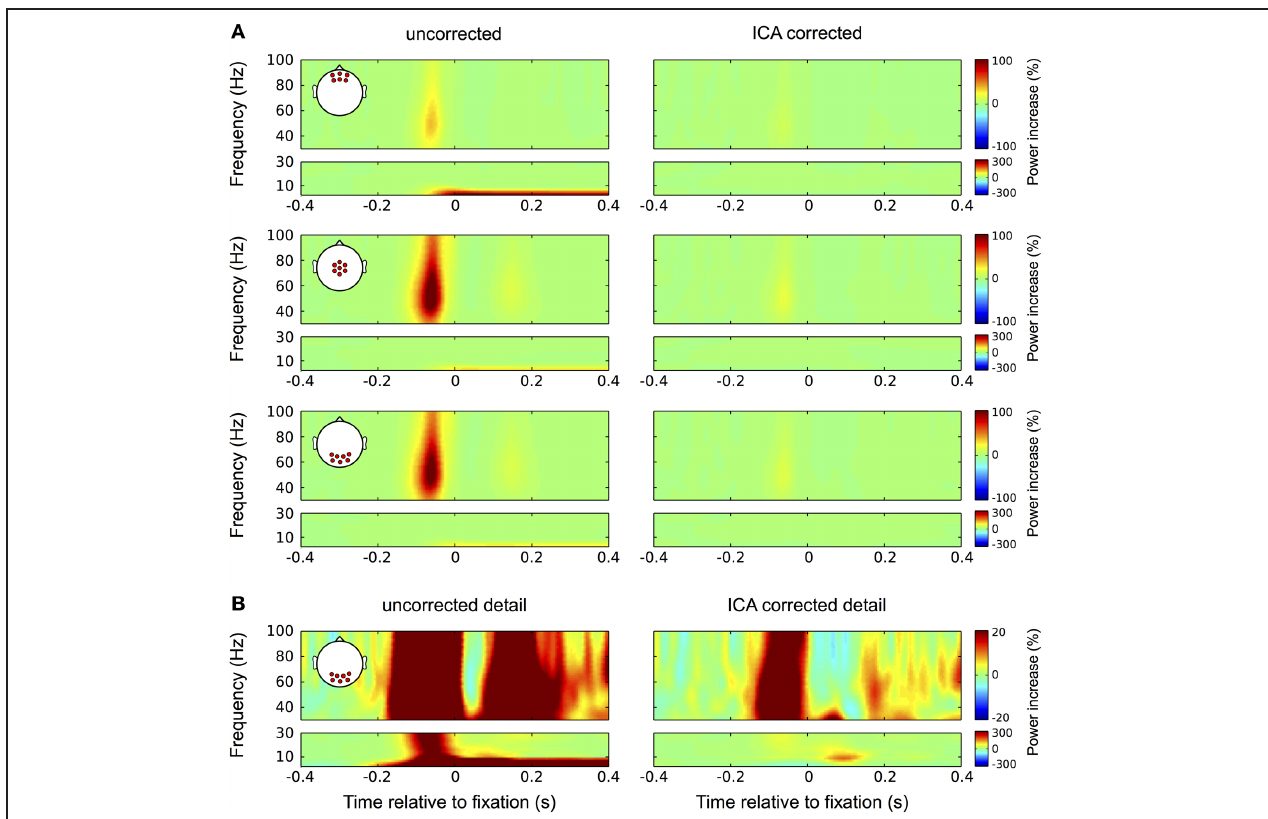
FIGURE 10 | Correction in the time-frequency domain. (A) Correction of eye movement artifacts in the high (larger boxes) and low (smaller boxes) frequency ranges at frontal (top panel), central (second panel), and occipital (bottom panel) electrode sites. Left column: In the high frequencies (30–100Hz) the uncorrected data display the typical broadband gamma burst-related to the spike potential at saccade onset. Corresponding with the topography of the spike potential this burst is most pronounced at central and occipital channel locations. As a result of small correctional saccades, a similar but much weaker burst is observed about 180ms after fixation onset. In the low frequencies ( < 30Hz) the corneo-retinal dipole offset leads to a prolonged increase in power below 10Hz, which is starting at saccade onset and manifests itself most prominently at frontal electrode sites. Right column: In concordance with the observation for ERP data, ICA correction significantly reduces the spike potential-related gamma burst and completely